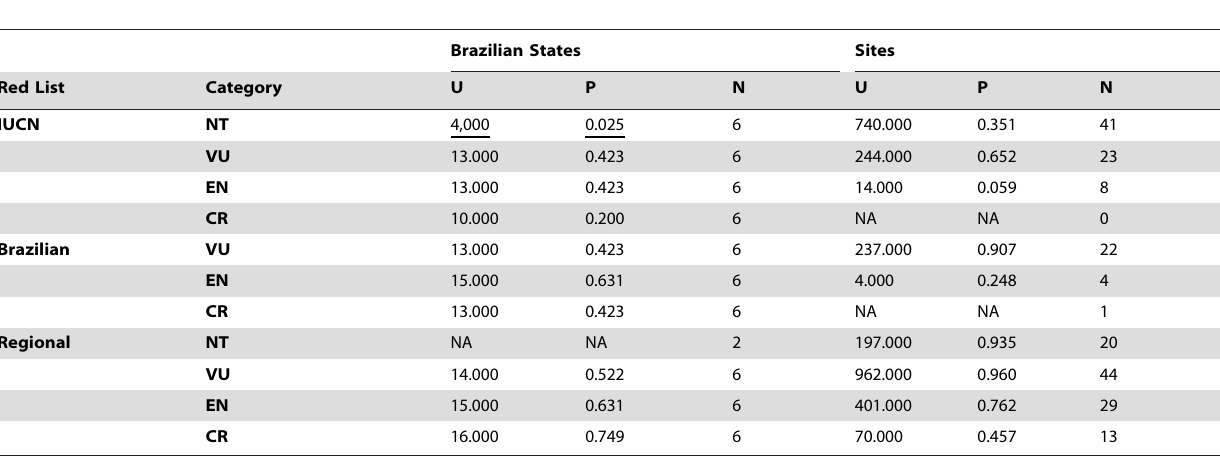
Table 3. Results for the Mann-Whitney tests comparing values of observed functional diversity and mean of randomized functional diversity of the analyzed Brazilian States and sites with threatened birds in categories of the IUCN, Brazilian and respective States Red Lists (see Supplementary Material for more information).